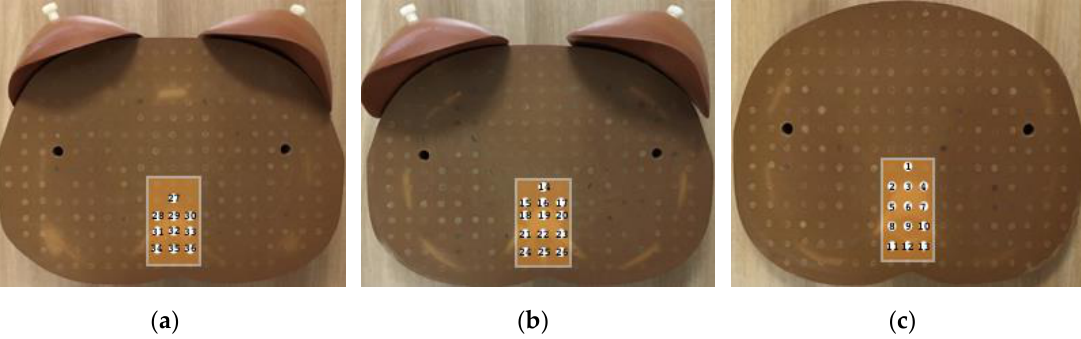
Figure 2. Position of radiochromic films (orange squares) and TLDs (white points) on the axial plane of the phantom slabs. ( a ) 17th slab: numbered positions from 27 to 36; ( b ) 18th slab: numbered positions from 14 to 26; ( c ) 19th slab: numbered positions from 1 to 13. Table 2. Calibration step: X-ray-tube output and dose values.